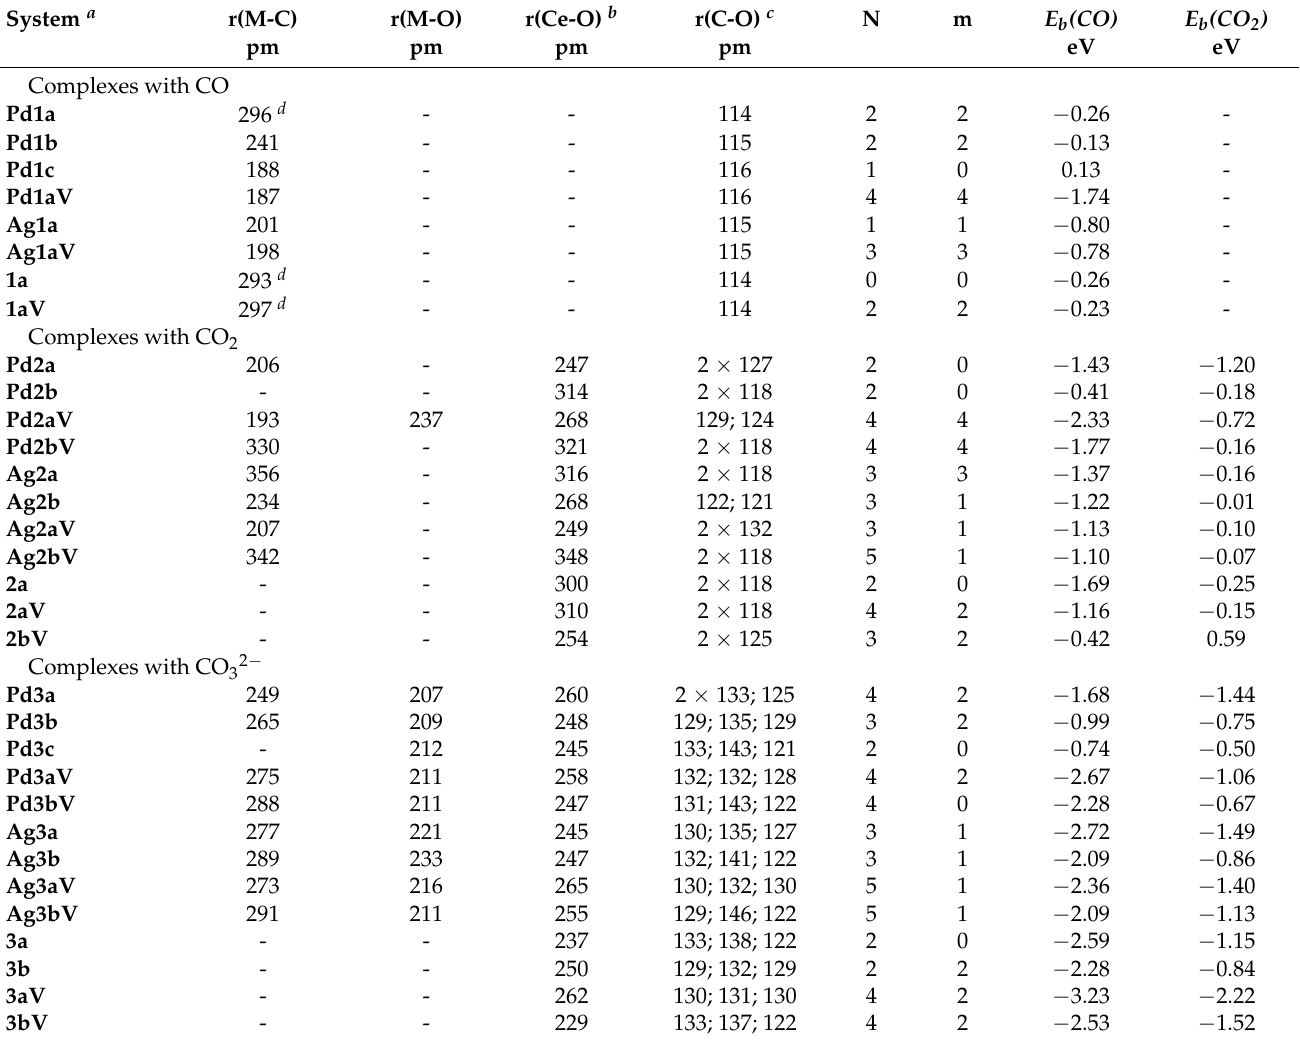
Table 1. Calculated parameters of the surface complexes shown in Figures 2–4, created by the interaction of CO with the Ce 3+ ions—N, difference between the numbers of spin-up and spin-down electrons—m, binding energies of CO— E b